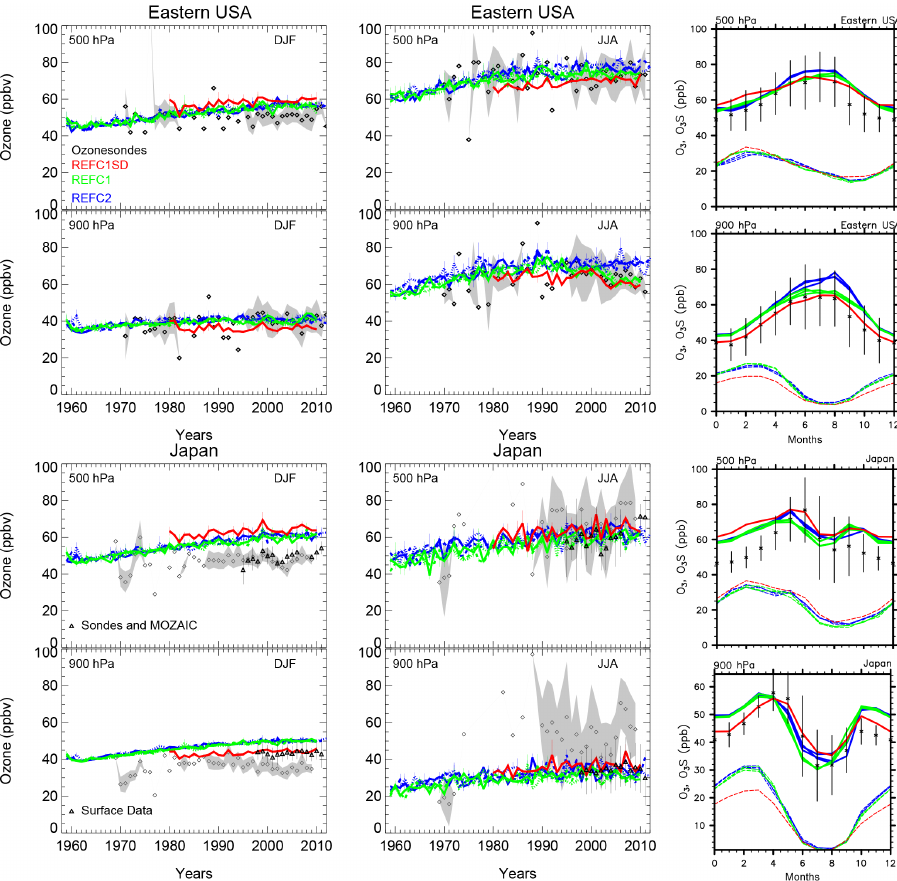
Figure 4. As Fig. 3, but for Eastern USA and Japan instead. For Japan, ozone time series compiled by Tanimoto et al. (2015) are added (black triangles) (see text for more details) and used to compare with the seasonal cycle of the model for